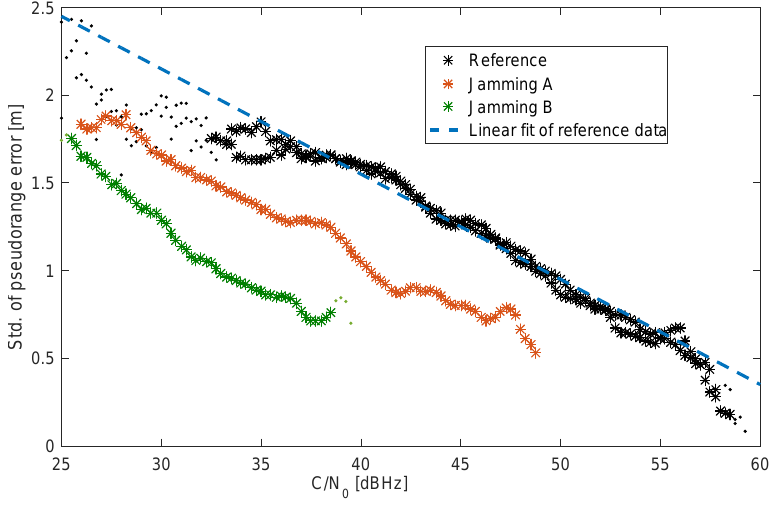
Figure 8. Recorded dependency of the pseudorange error statistics on the receiver reported CN0 value for lab